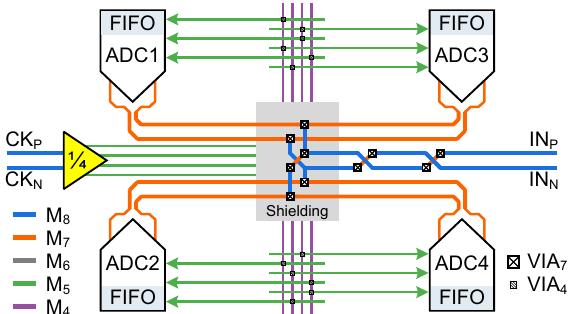
Figure 6. Input and clock routing